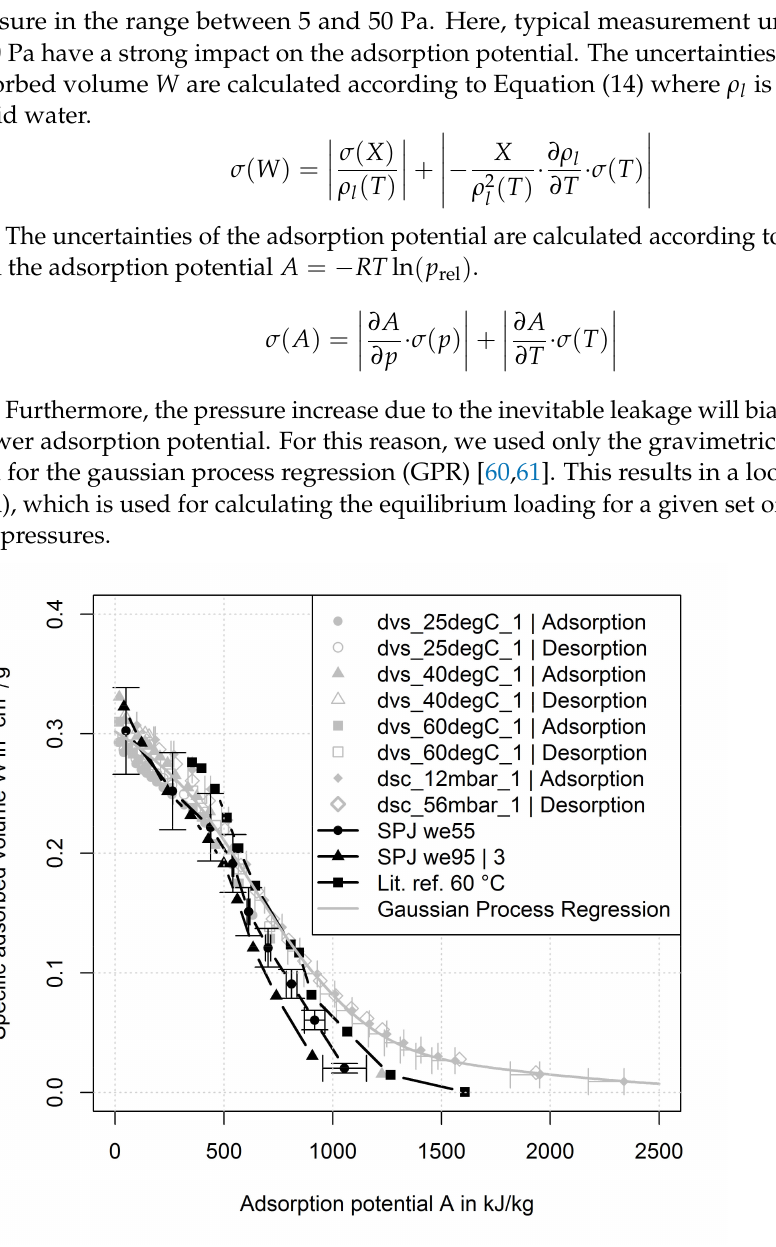
Figure 6. Dubinin-transformed equilibrium data for different gravimetric measurements of powder material (“dvs” and “dsc” measurements) and the volumetric measurements of samples we55 and we95 (“SPJ” measurements) as well as a dataset of Pinheiro et al. [57] (“Lit. ref. 60 ◦